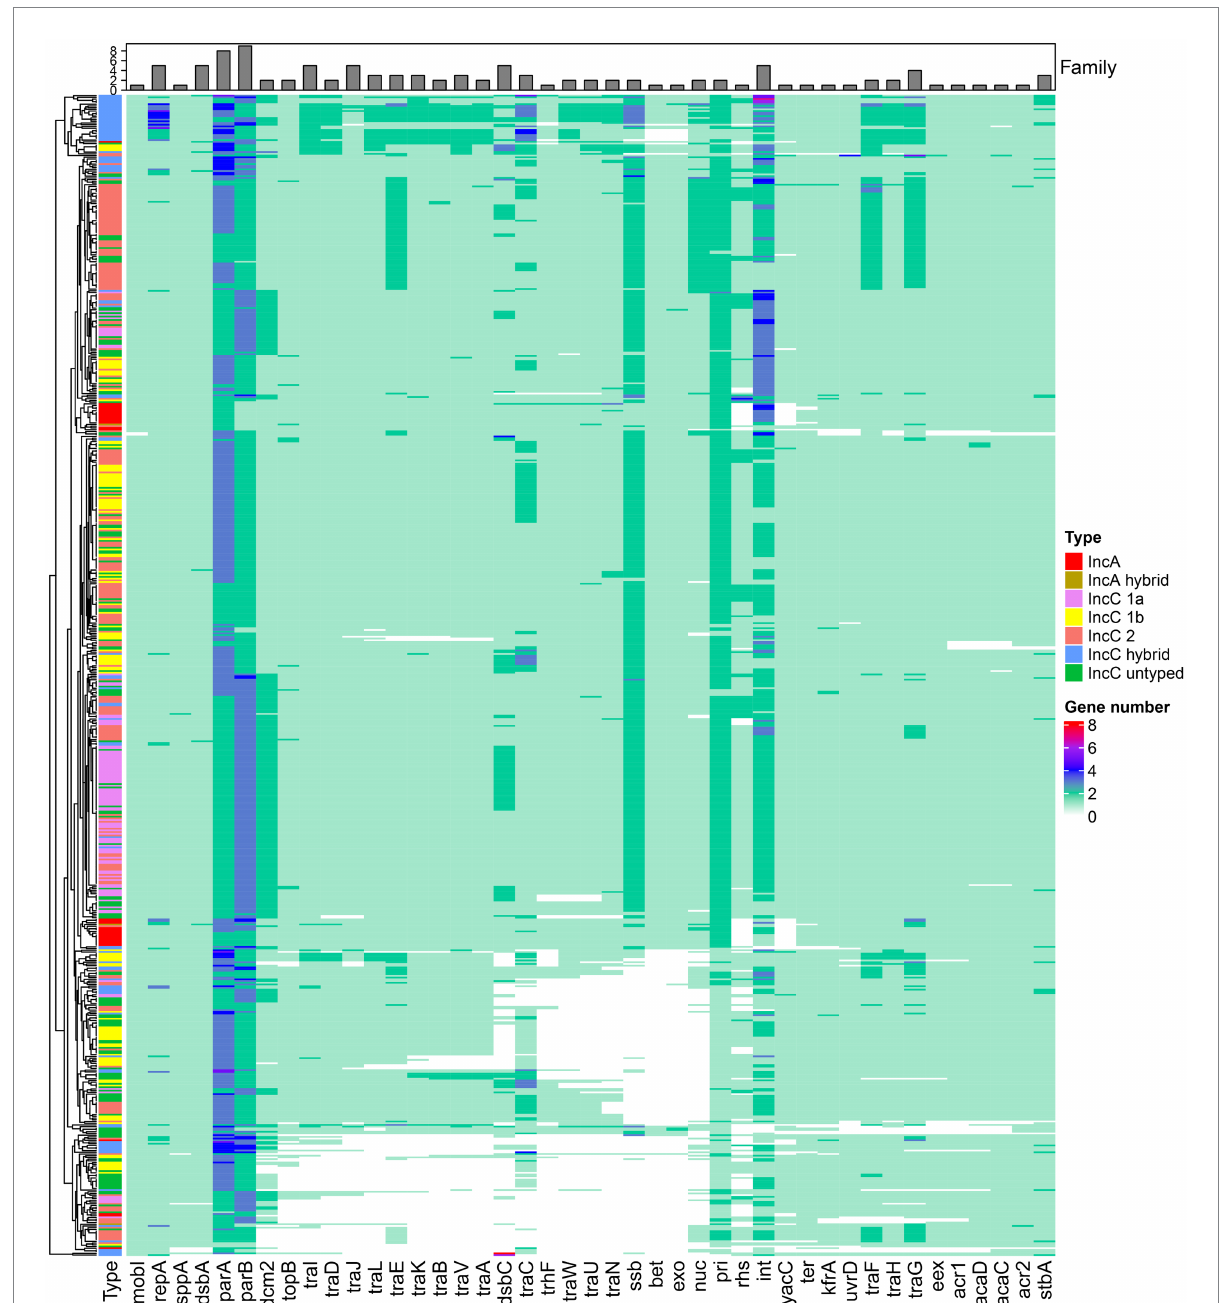
FIGURE 2 The distribution of core functional genes in plasmids. The heatmap represents the presence, absence, and abundance of core functional genes in different types of IncA and IncC plasmids. The bar plot on the top shows the family amount for